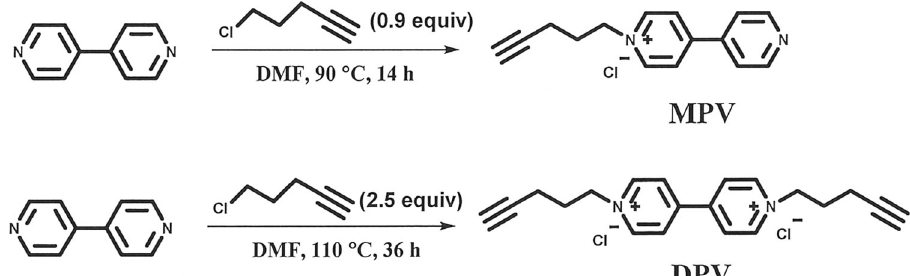
Fig. 1 Synthetic route of MPV and DPV. One-step synthesis of mono- or di-substituted viologen compounds.